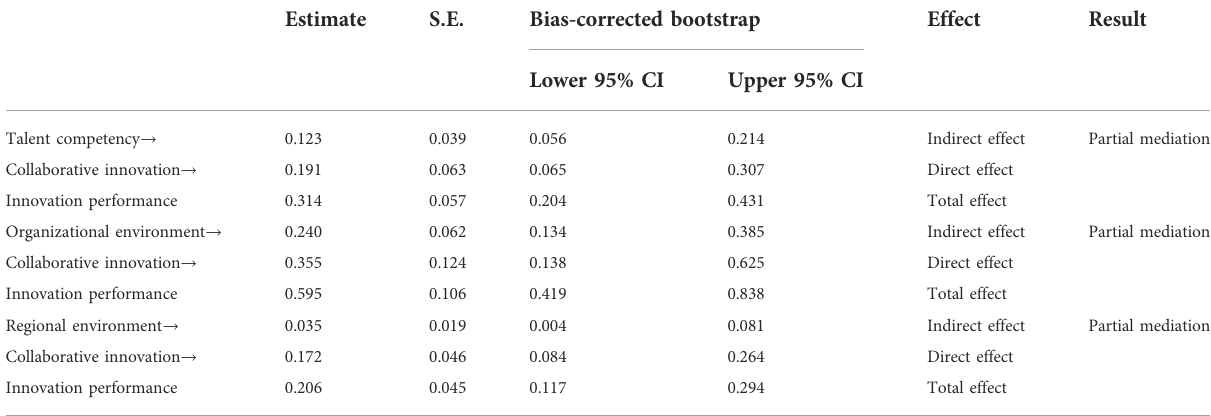
TABLE 5 Results of the test of the mediating effect of collaborative